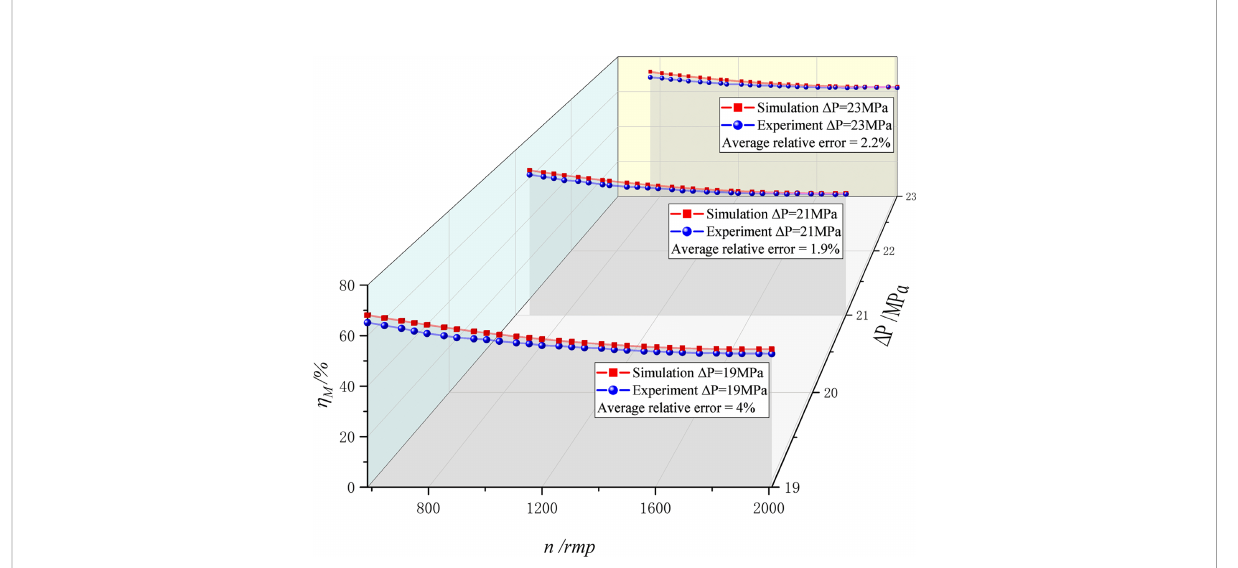
FIGURE 9 The comparison between the simulation and experimental results of the mechanical ef fi ciency